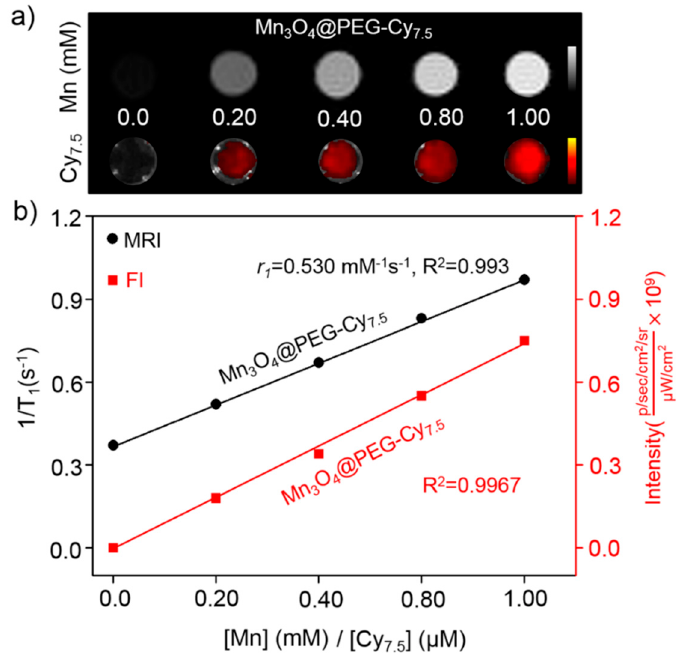
Figure 2. The relaxation and fluorescent properties of Mn 3 O 4 @PEG-Cy 7.5 NPs. ( a ) T 1 -weighted magnetic resonance (MR) and fluorescent imaging of Mn 3 O 4 @PEG-Cy 7.5 NPs; ( b ) T 1 relaxivity plot and fluorescent intensity of aqueous suspensions of Mn 3 O 4 @PEG-Cy 7.5 NPs on a 7 T magnetic resonance imaging (MRI) and fluorescent imaging system.